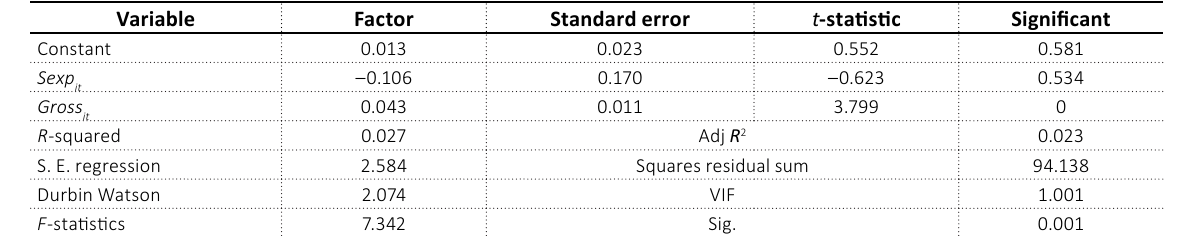
Table 5. Model 1 results